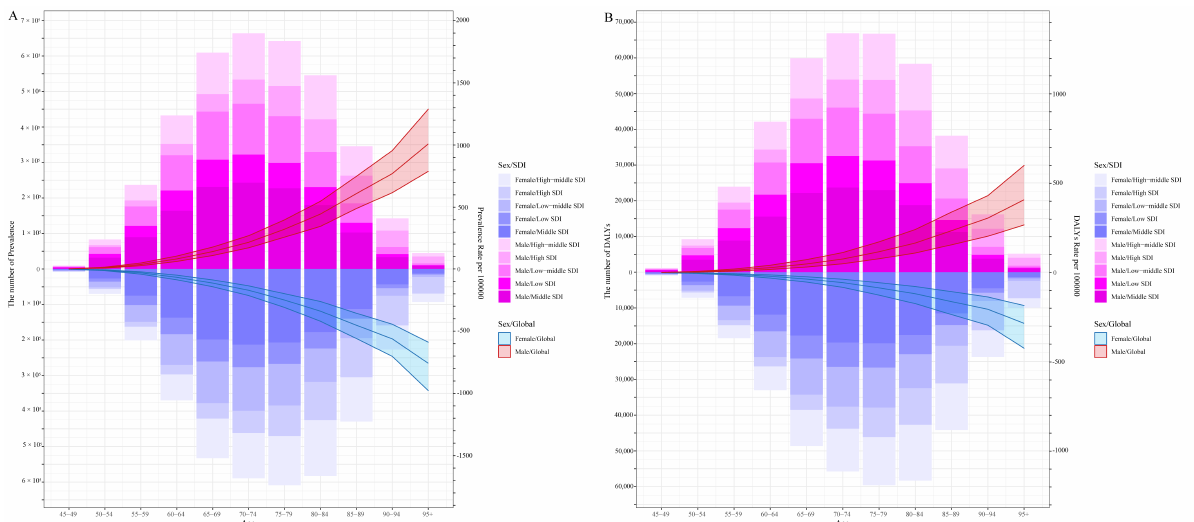
Figure 1. The number and age-standardized prevalence ( A ) and DALYs ( B ) in 2019 reported by sex, age, SDI region. DALYs: disability-adjusted life-years; SDI: sociodemographic